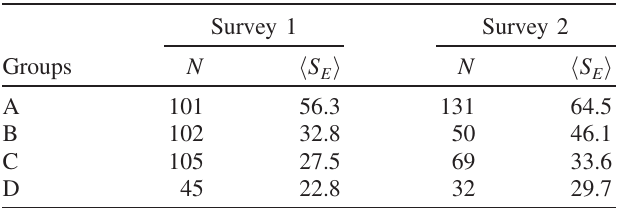
TABLE IV. Sample size ( N ) and average epistemic scores i ) of the groups A,B,C, and ( h S E